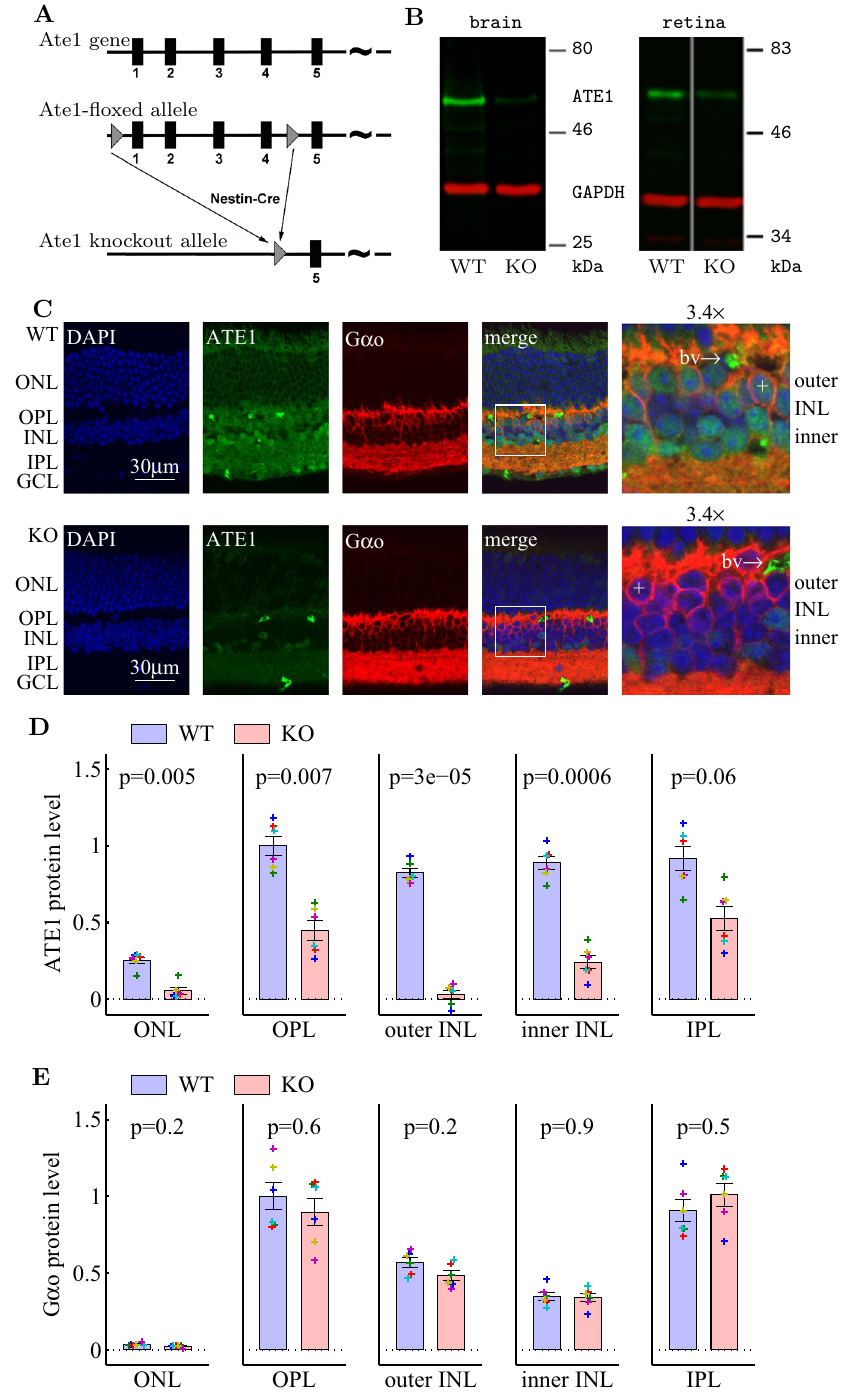
Figure 1. Deleting Ate1 in the brain and the retina. ( A ) Strategy for generating Ate1 conditional knockout (KO) mice. ( B ) Western blots using ATE1 antibodies confirm near-absence of ATE1 in the brain (left) and significant reduction of ATE1 in the retina (right) of Ate1 KO mice. Western blots were performed on brain and retina lysates from littermate pairs of wild type (WT) and KO mice. For the retina blot, WT and KO pair were on the same blot but not on the adjacent lanes. ( C ) Immunohistochemistry of central retina sections stained with anti-ATE1 (green) in WT (top) and KO (bottom), together with the G-protein G α o (red, the marker for the ON bipolar cells) and DAPI (blue, the marker for the nuclei). The right-hand images show a 3.4x magnification of the regions of the retina shown on the left. The + signs mark two representative WT and KO ON-bipolar cells, respectively. Shown here are original images of KO and WT processed at the same time with the same settings. See Fig. S1A for the corresponding images with background subtraction and/ or scaling. The WT retina has clear ATE1 staining in the ONL, OPL, INL, IPL, GCL, and ON-bipolar cells; this ATE1 staining is greatly reduced in KO except bright spots that stained blood vessels (marked ‘bv’) and a few cells in INL near the border with IPL. See Fig. S1B for another example. IPL/OPL: inner/outer plexiform layer. INL/ONL: inner/outer nuclear layer. GCL: ganglion cell layer. ( D ) and ( E ), Quantification of ATE1 and G α o levels in different retinal layers. The error bars represent SEM and the p-values are from paired Student’s t-test on 6 pairs of retinal sections from WT and KO littermates. Data points from each pair are plotted with a unique